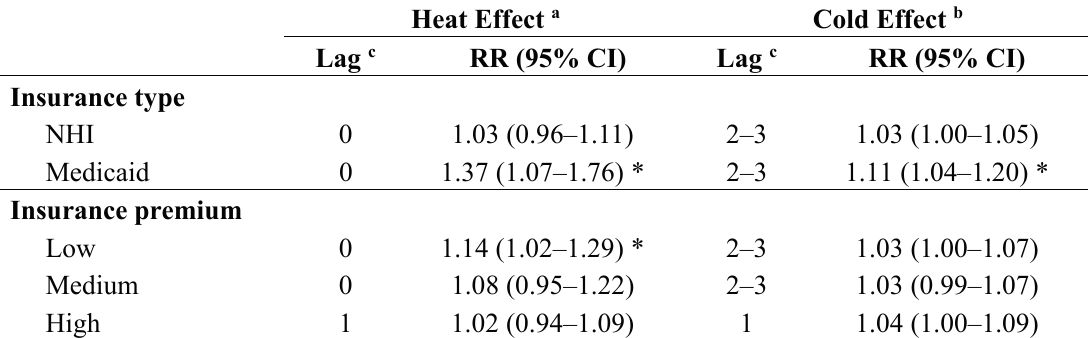
Table 5. The relative risk (RR) of heat and cold effects on AMI hospital admissions in hot and cold weather period by insurance type and premium.